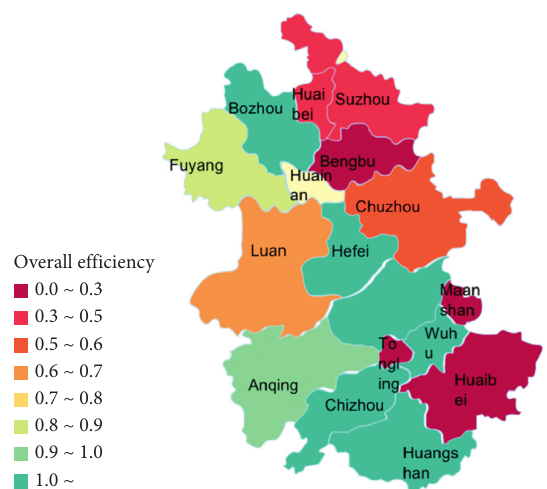
Figure 5: Overall efficiency